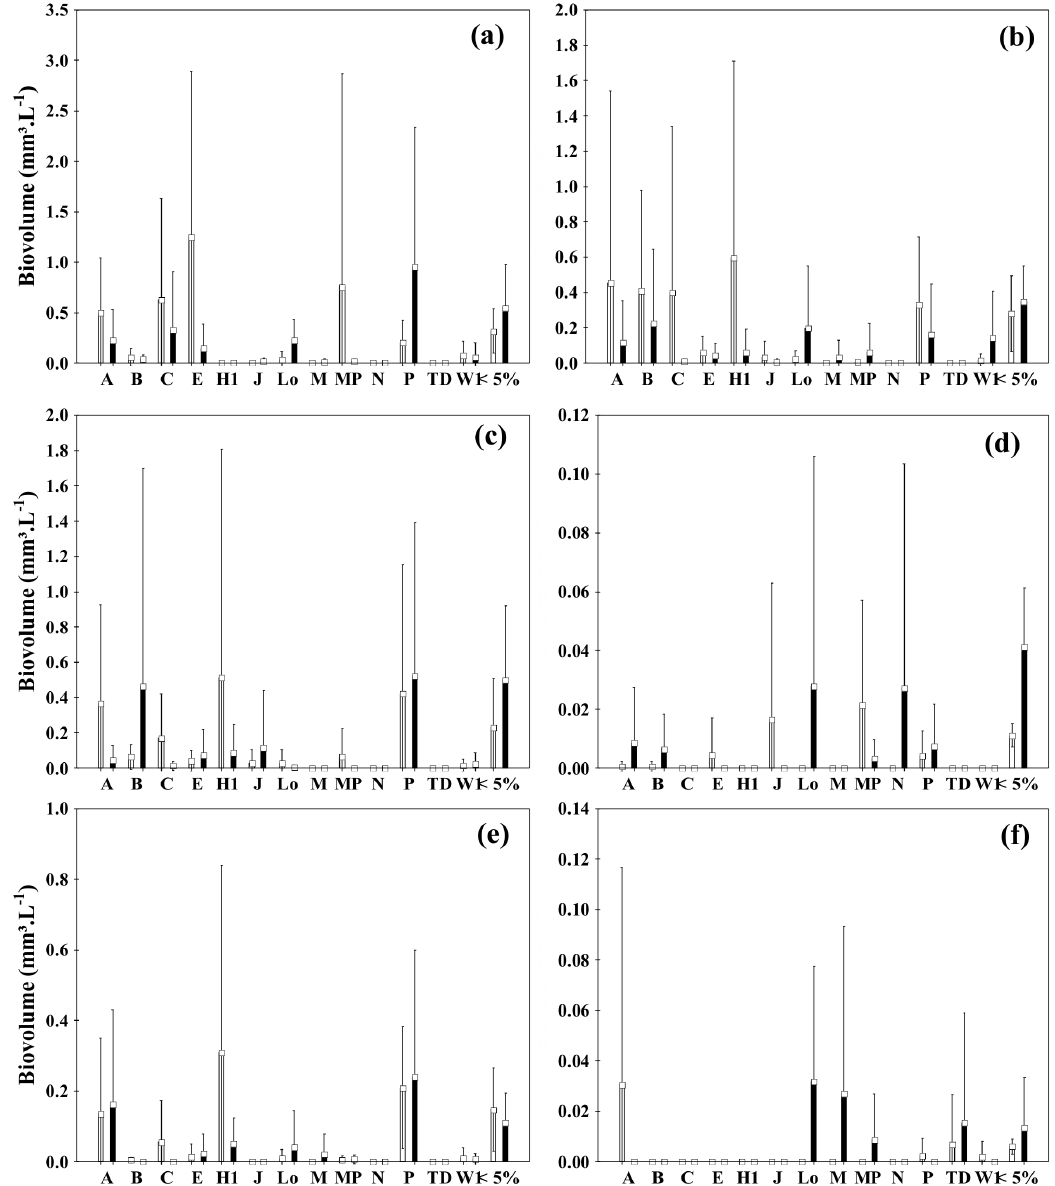
Figure 5. Biovolume of the phytoplankton FGs in the sampling sites from March 2010 to December 2013 (a = L1; b = L2; c = L3; d = R3; e = R2; f = R1. <5% - Total biovolume of taxa with less than 5%; white bar= dry; black bar=